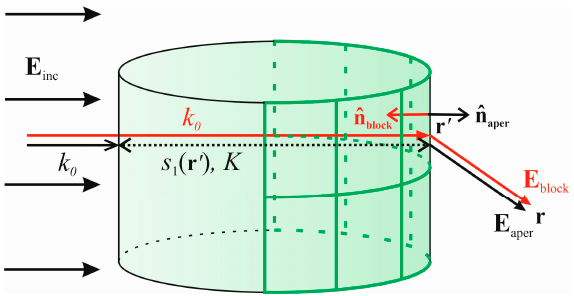
Figure 3. The blockage fields can be obtained with (cid:1814)(cid:3549) = (cid:1814)(cid:3549) (cid:2912)(cid:2922)(cid:2925)(cid:2913)(cid:2921) , as shown in Figure 3. For more details see [7].